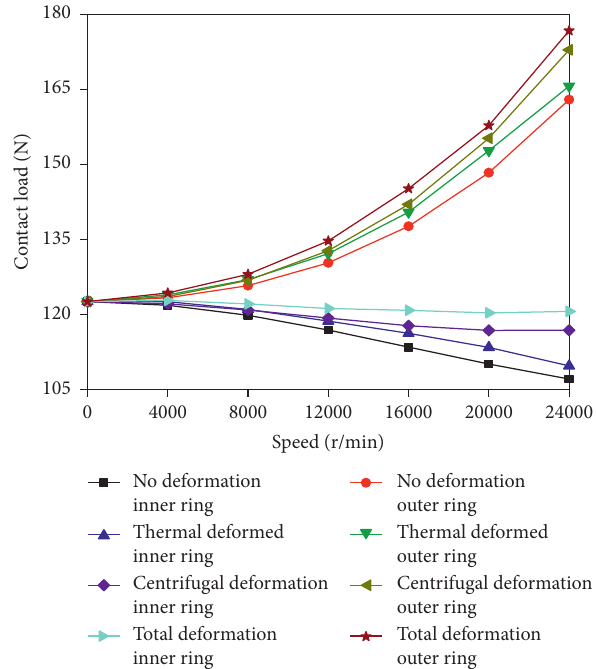
Figure 15: Influences of the speed and deformation on contact